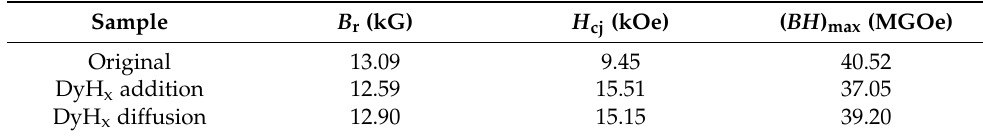
Figure 1. ( a ) The demagnetization curves of the original magnet, the DyH x addition magnet, and the DyH x diffusion magnet; ( b ) the variation curves of the corresponding B r , H cj , and ( BH ) max of the three types of magnets derived from ( a ). Table 1. The room temperature magnetic properties of the magnets.